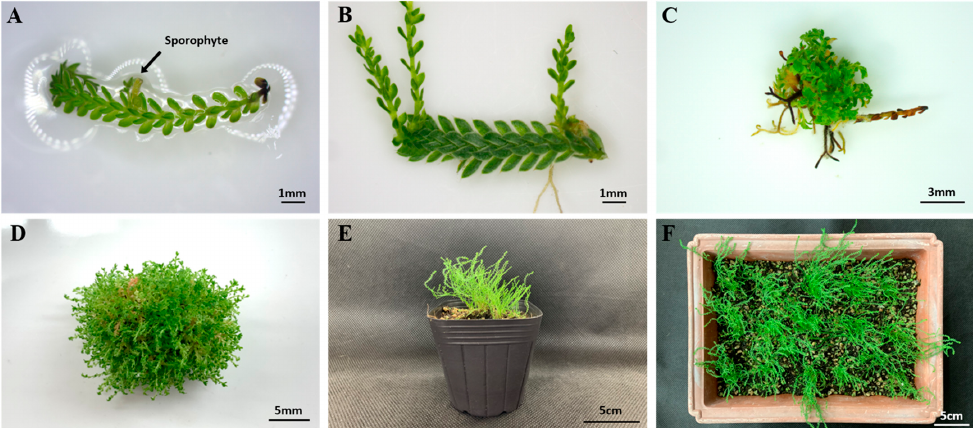
Figure 3. Propagation and acclimation of S. tamariscina (P.Beauv.) Spring regenerated from the shoot tip of a sporophyte. ( A ) A 12 mm shoot tip. ( B ) Sporophytes regenerated in various parts of the shoot tip. ( C ) Explant after an 8-week culture with large amounts of sporophytes. ( D ) Sporophytes formed from explants at week 12 of culture. ( E ) Sporophyte acclimated for 12 weeks under a controlled environment. ( F ) S. tamariscina adaption in